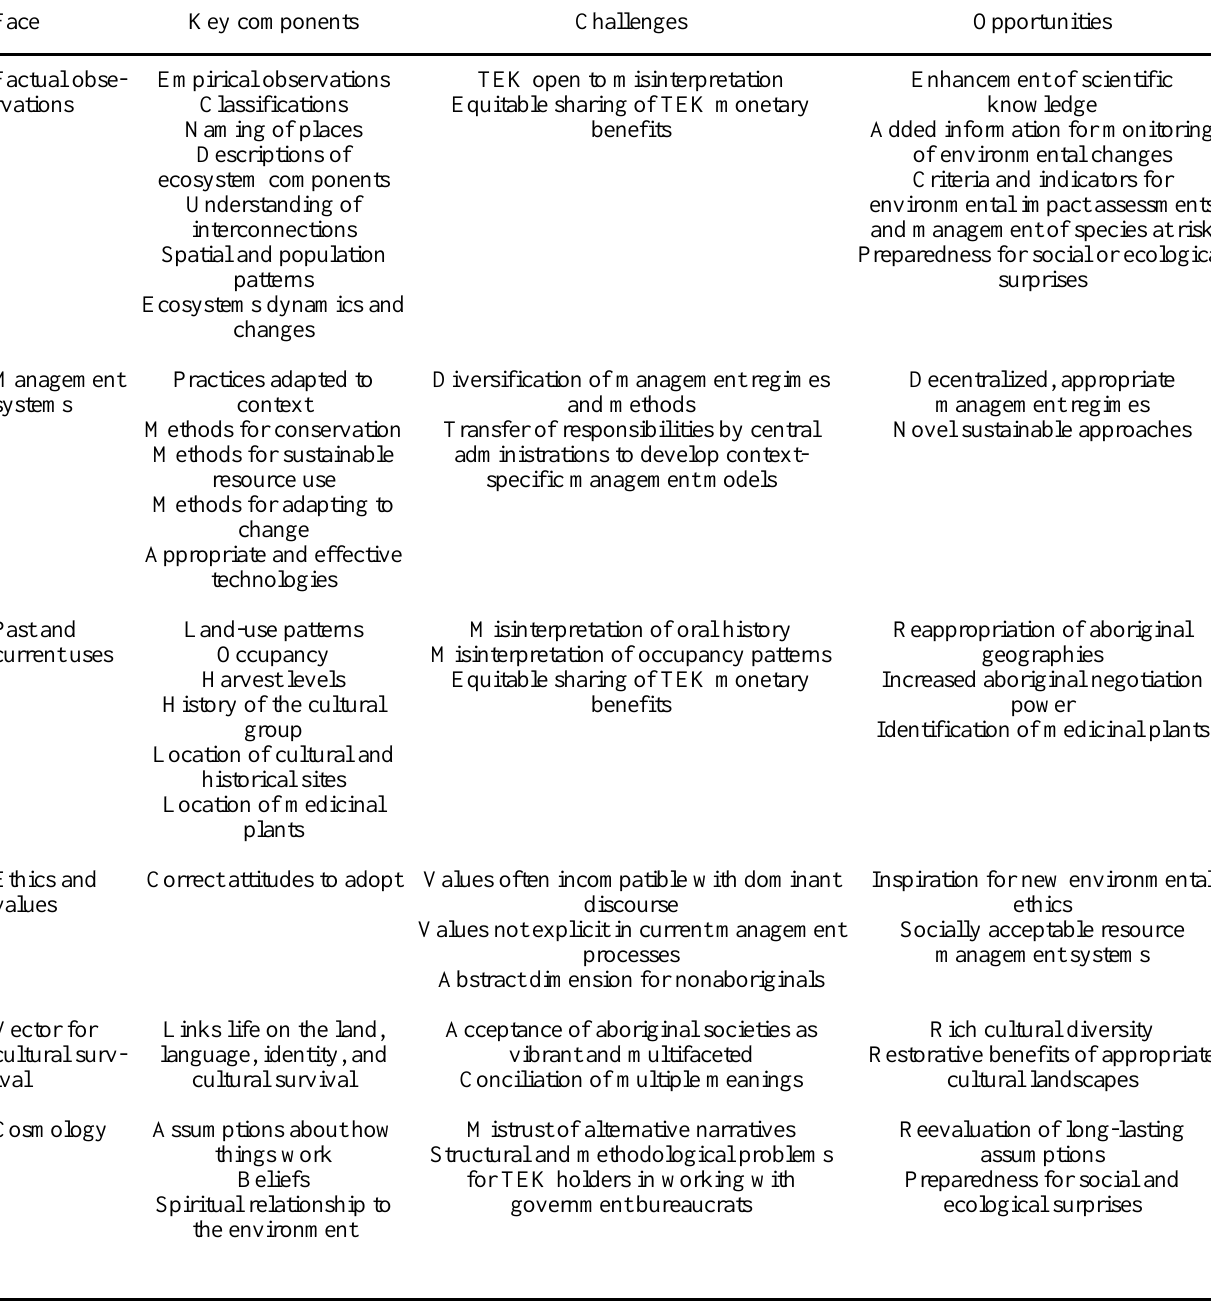
Table 1. Characteristics of the six faces of traditional ecological knowledge (TEK).